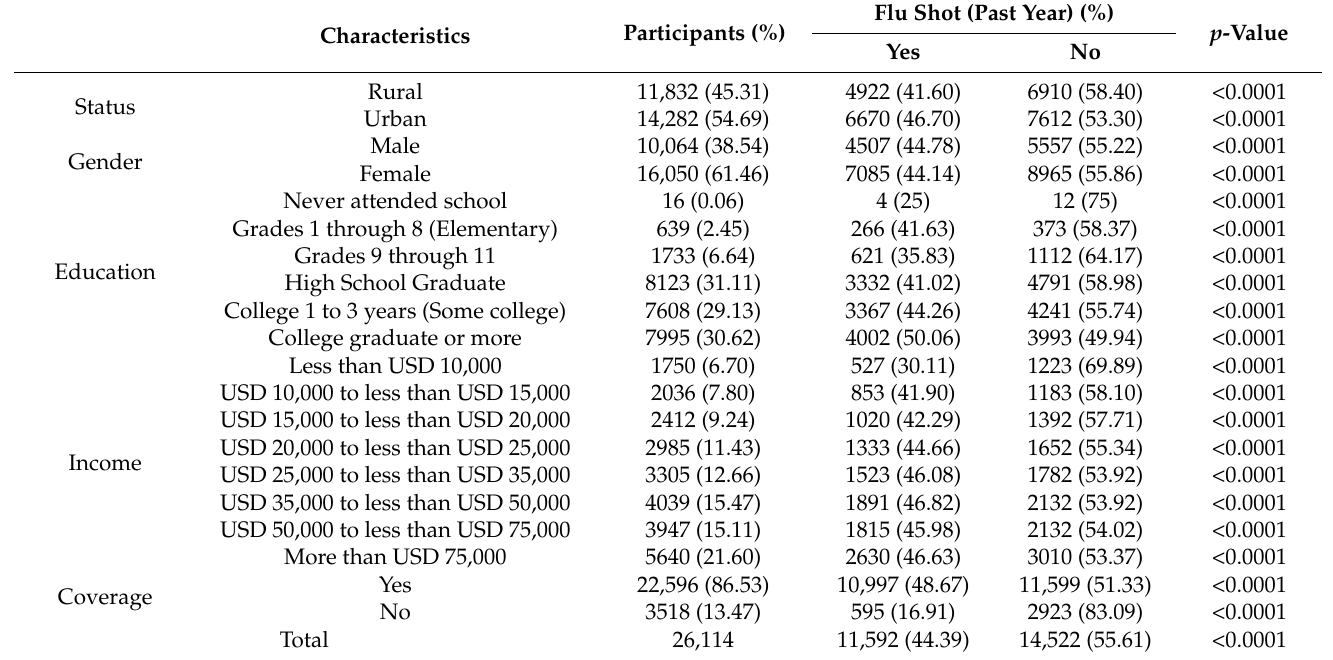
Table 1. Participants’ baseline